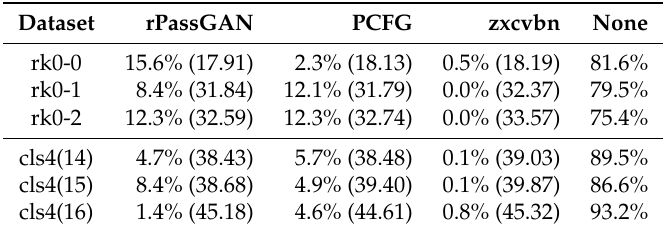
Table 5. Percentage of the lowest entropy cases for each